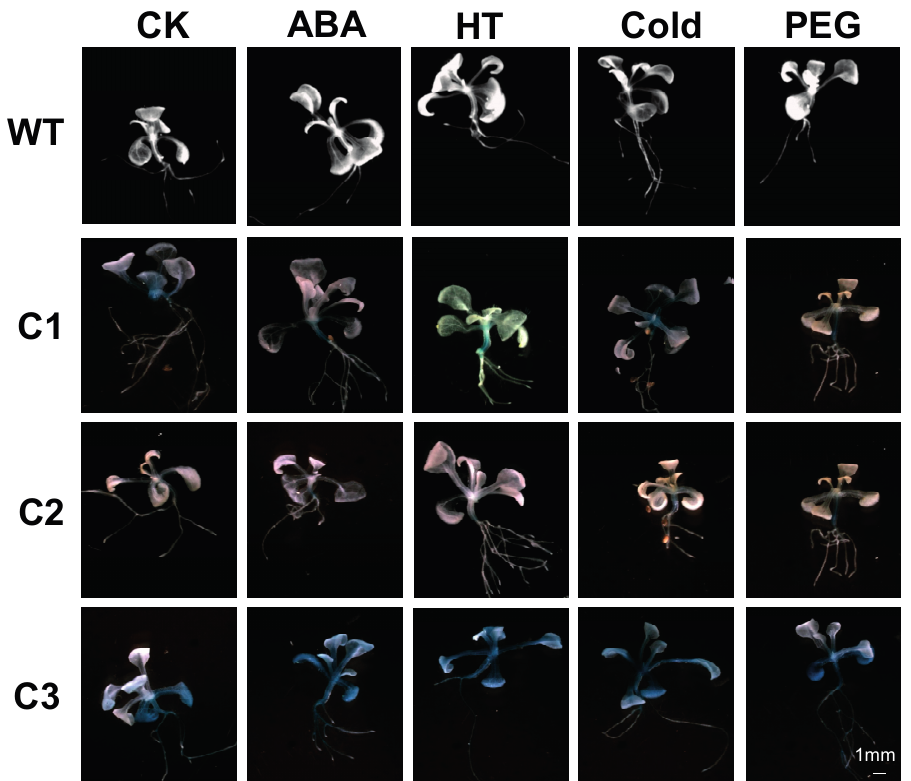
Figure 4. Histochemical expression of the β -glucuronidase (GUS) reporter gene in transgenic Arabidopsis and wild type (WT) in response to abiotic stresses and abscisic acid (ABA). Two-week-old Arabidopsis T3 plants were subjected to ABA, high temperature (HT), cold (4 °C), and drought (20% PEG6000) treatments for 6 h. Control (CK) plants were treated with water. C1, C2, and C3 represent different deletion promoters. Scale